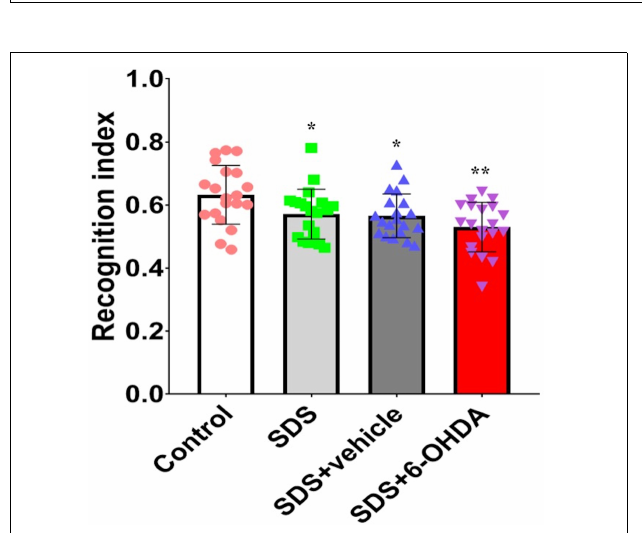
FIGURE 7 | Effects of social defeat stress on the number of social interaction in the 6-OHDA lesioned mice. * p < 0.05, ** p < 0.01, compared with the control group; † p < 0.05, †† p < 0.01, when compared with the social defeat group ( n = 20 per group).